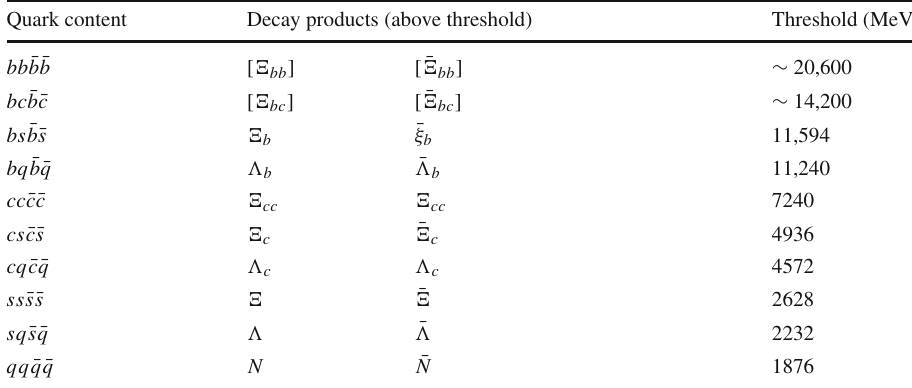
Quark content Decay products (above